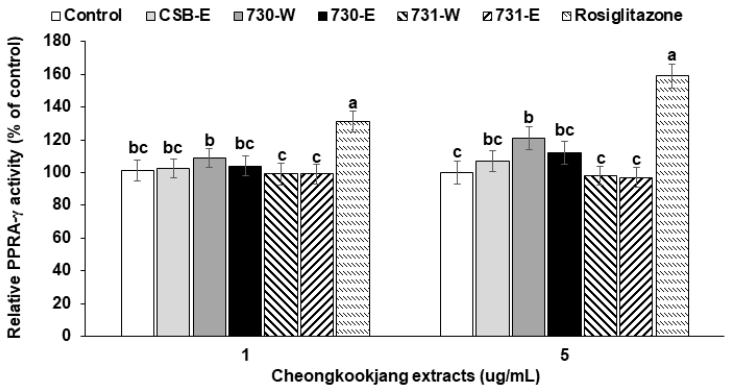
Figure 3. Peroxisome proliferator-activated receptor (PPAR)-γ activation in human embryonic kidney 293 cells. 3T3-L1 adipocytes were pre-treated with the 48 h-treatment of the ethanol (-E) and water (- W) extracts (1 and 5 μg/mL) of cooked soybeans (CSB), chungkookjang fermented with B.